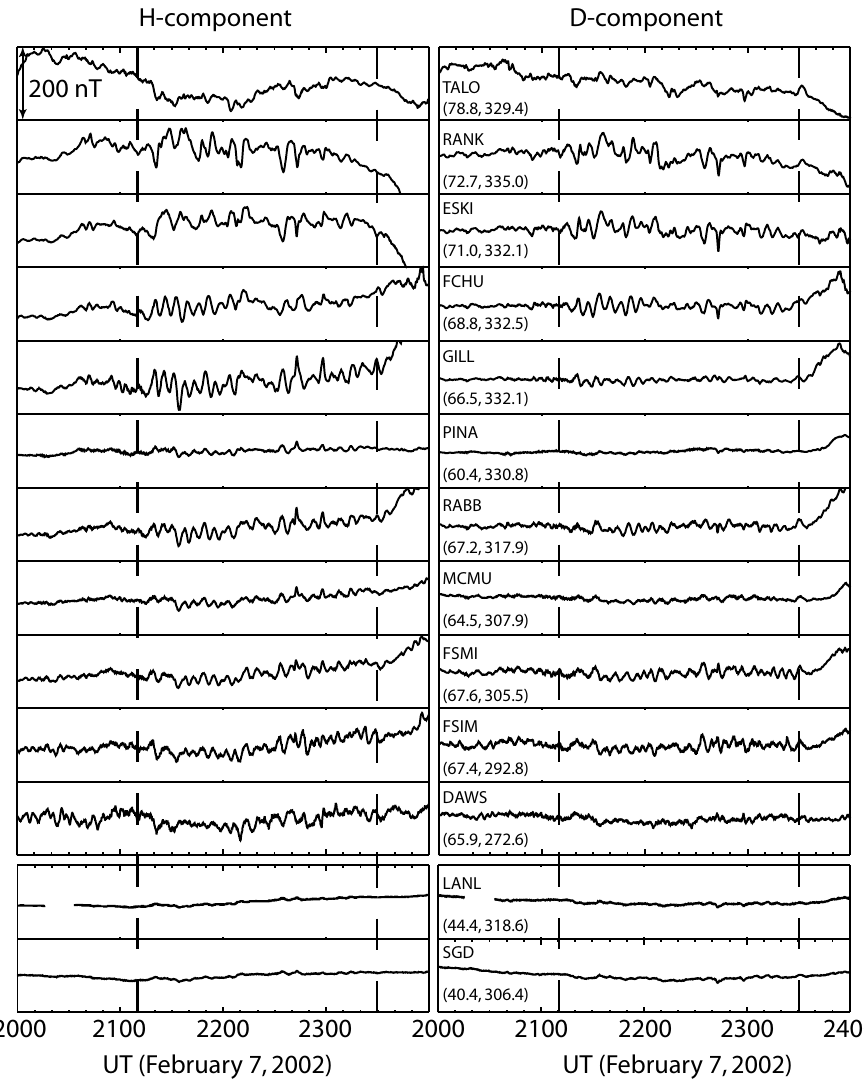
Fig. 10. The stacked horizontal components ( H and D ) of the magnetic field from the stations in the North American sector for a 4-h period from 20:00 to 24:00 UT. In each right panel, the numbers next to the station name give the CGM latitude and longitude of the